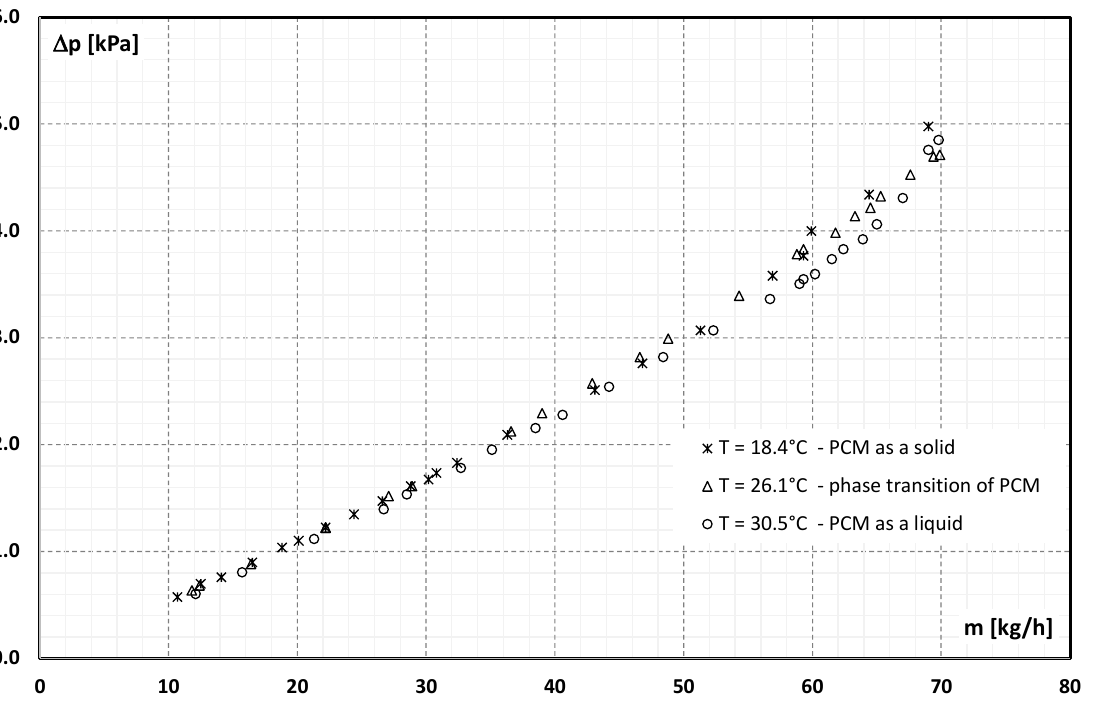
Figure 4. The dependency of pressure drop of the slurry (21.5% MPCM) in a tube 400 mm long and 4 mm d i on the mass flow rate and temperature.